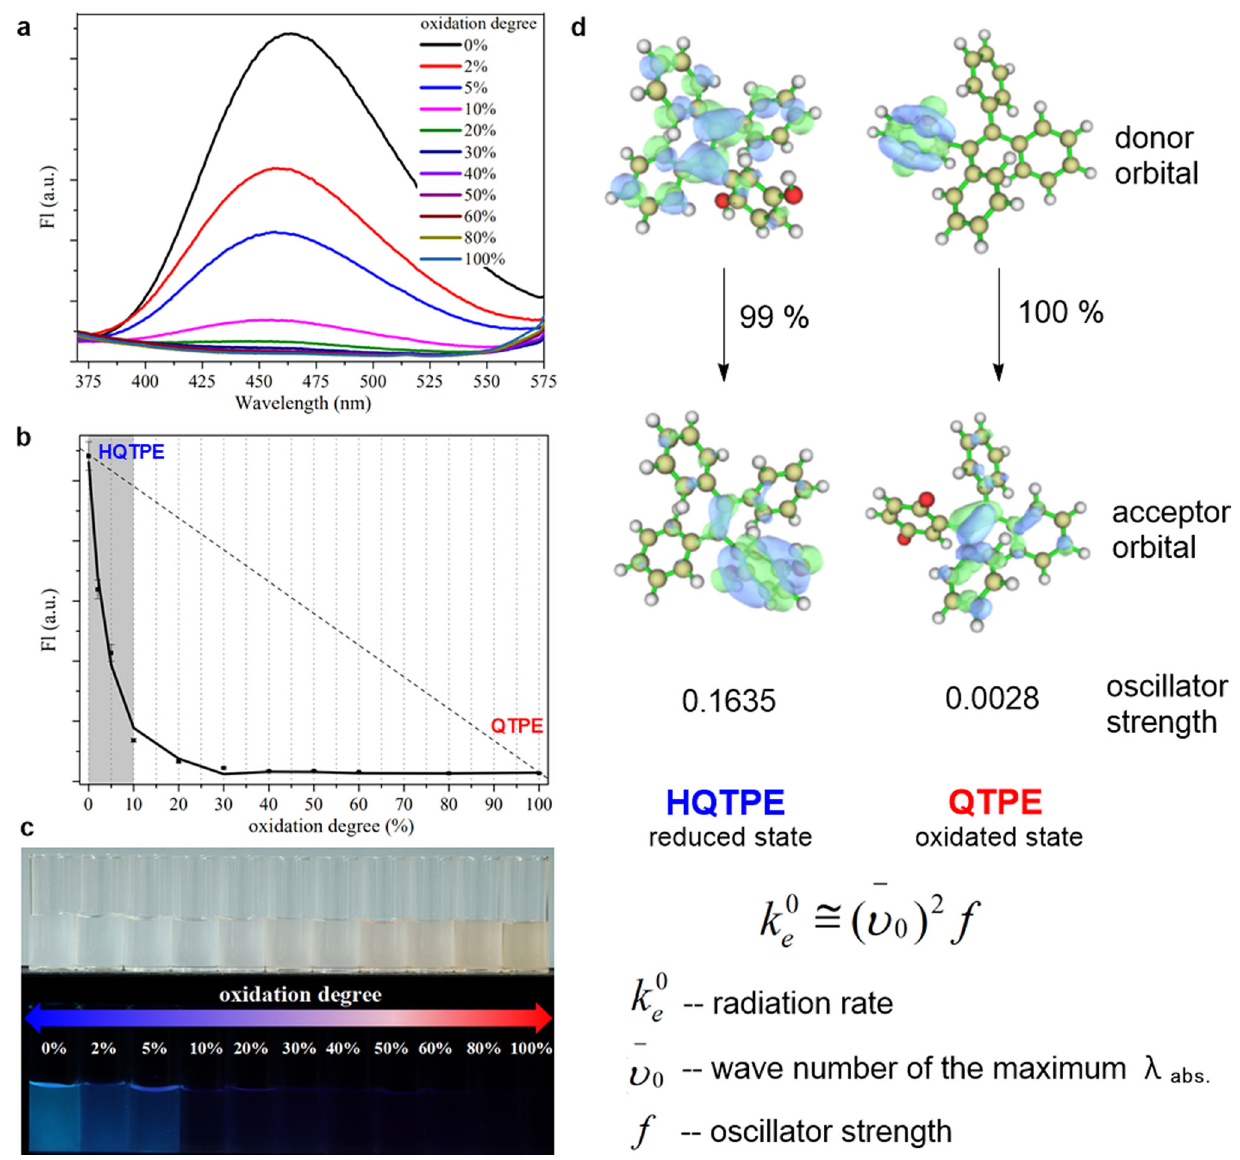
Fig. 4 Intermolecular fl uorescence quenching of HQTPE during oxidation, simulated by separately adding HQTPE and QTPE at various ratios. a Fluorescence spectra of 100 μ M HQTPE/QTPE with different degrees of oxidation, at excitation wavelength of 300 nm. b Fitting curve of the fl uorescence intensity of HQTPE/QTPE solutions with different degrees of oxidation. Error bars show SDs of three independent measurements. c Photographs of HQTPE/QTPE solutions with different degrees of oxidation under white light or UV light. d The natural transition orbitals (NTOs) pairs describing S 0 – S 1 transition and corresponding oscillator strength of HQTPE and QTPE. Numbers near the arrow indicate the contribution percentage of displayed NTO transitions to the corresponding S 0 – S 1 transitions.Calculated at optimized S 1 geometry using TD-DFT